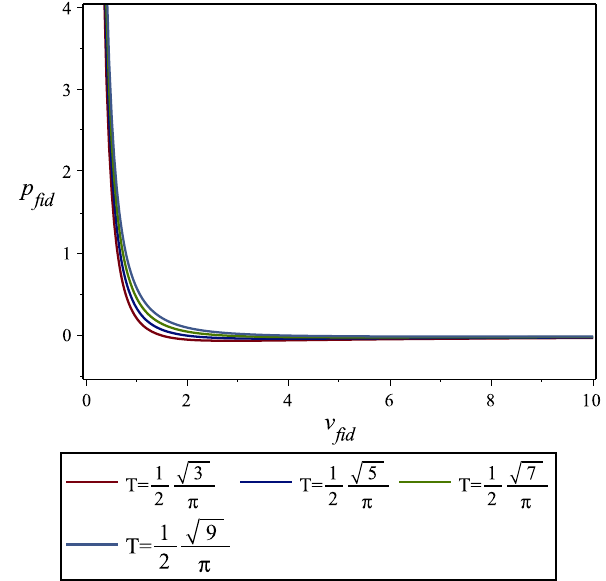
Fig. 12 P – V diagramsforfidelityversuspressure.Weaddressvarious temperatures of RNSAdS black holes. We indicate that fidelity does indeed represent thermodynamic volume